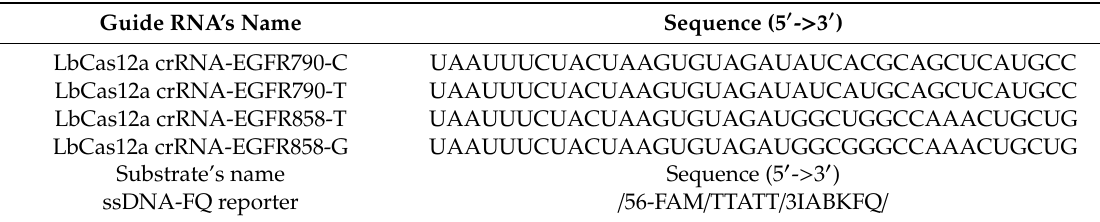
Table 2. Sequences of guide RNA and reporter